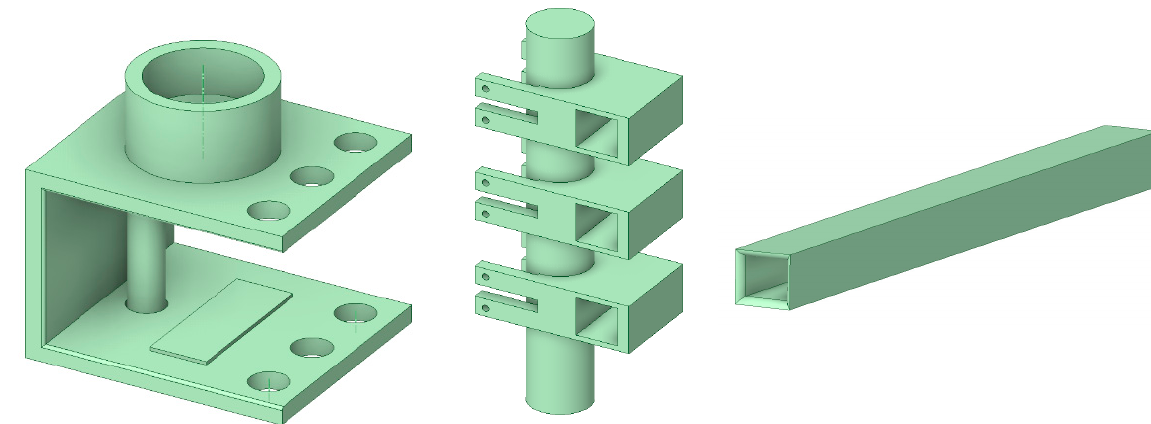
Figure 2. Schematic diagram of each component of the assembled bridge guardrail.